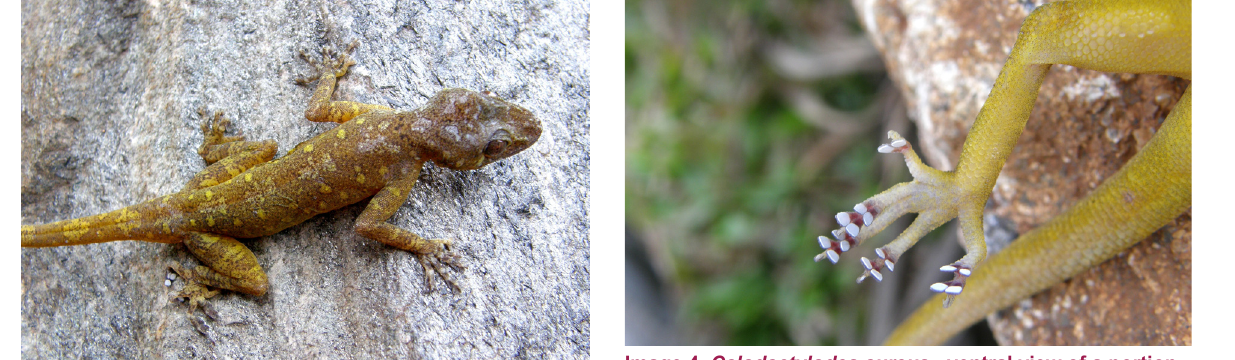
Image 4. Calodactylodes aureus - ventral view of a portion of hind leg and tail